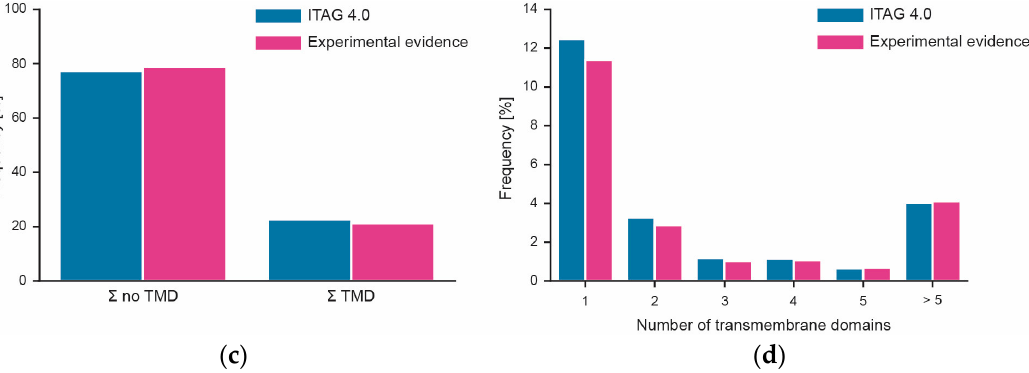
Figure 6. Assessment of workflow bias. ( a ) Distribution of the molecular weights of all proteins in ITAG 4.0 vs. proteins identified in this study; ( b ) same as panel ( a ) but for peptide hydrophobicity (expressed as GRAVY index). ( c ) Fraction of proteins with or without predicted transmembrane domains (TMF) in ITAG 4.0 or identified in this study. ( d ) Percentage of proteins with different numbers of predicted transmembrane domains in ITAG 4.0 or identified in this study.